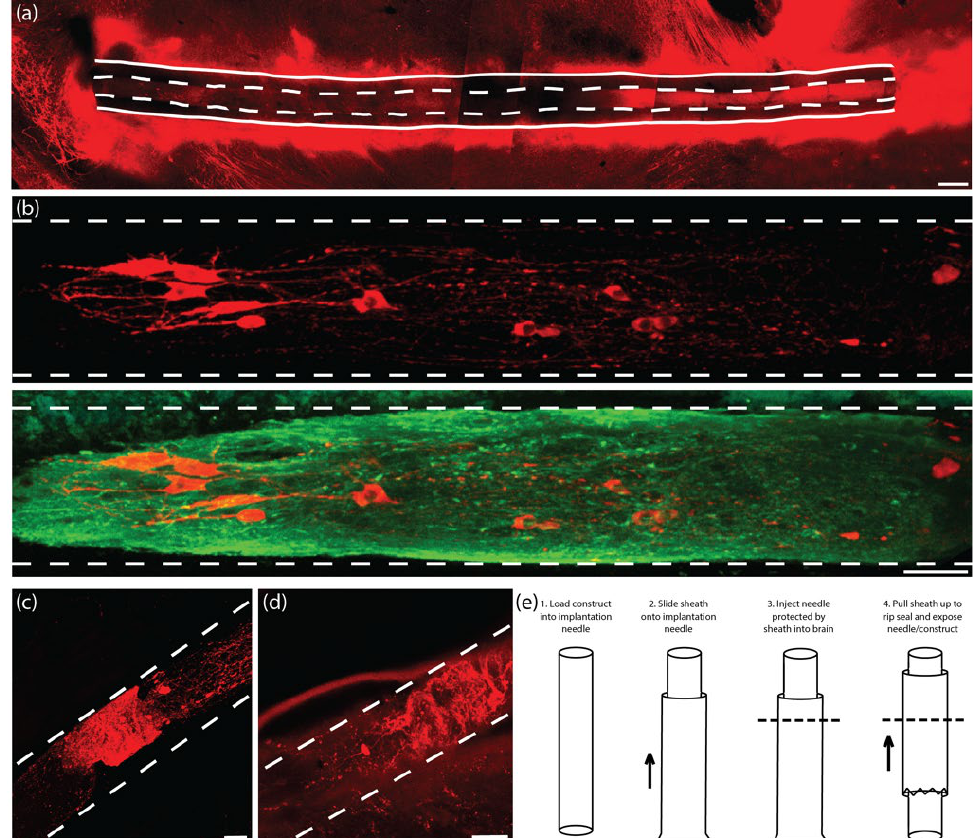
Figure 6. Development of histological and transplantation methodologies. In comparison to conventional sectioning methods, the use of tissue clearing allowed for complete visualization of the TE-NSPs in vivo while avoiding damage to the TE-NSPs during traditional thin sectioning. ( a ) Representative confocal reconstruction of an enriched TE-NSP immediately following implantation labeled via immunocytochemistry to denote dopaminergic neurons/axons (TH, red). Tissue clearing enabled a global perspective on implant integrity and trajectory. ( b ) Representative confocal reconstruction of an enriched TE-NSP immediately following implantation labeled via immunocytochemistry to denote dopaminergic neurons/axons (TH, red) and all neurons/axons (β - tubulin III, green). Structures as small as neuronal somata and individual neurites could be imaged with ease using tissue clearing in conjunction with confocal microscopy. ( c , d ) Representative confocal reconstructions of enriched TE-NSP immediately following implantation labeled via immunocytochemistry to denote dopaminergic neurons/axons (TH, red). The original delivery process was found to occasionally damage the TE-NSP neurons and axonal projections due to the delivery needle coring out brain tissue. In these two examples, the TE-NSP axons within the lumen were compressed due to forces from cored brain tissue pushed into the needle (each large TH+ mass shows undulated axons within the lumen). ( e ) In order to prevent the compression of the TE-NSP by the brain during implantation, a needle sheath with a breakable seal was used to cover the end of the needle. This methodology consisted of the following steps: (1) The construct was loaded into the implantation needle; (2) once loaded, the sheath was slid onto the needle and completely covered the end of the needle (not shown); (3) the whole apparatus (needle and sheath) was lowered into the brain to the correct depth (the dashed line represents the brain surface); and (4) forceps were used to pull the sheath upwards, which breaks the seal on the end of the needle and left the construct exposed at the correct depth in the brain. As with the original methodology, a plunger was used to hold the TE-NSP in place while the needle and sheath were removed from the brain, thereby depositing the intact TE-NSP in the wake of the needle. Scale bar ( a ) = 200 µm. Scale bar ( b ) = 50 µm. Scale bar ( c , d ) = 50 µ